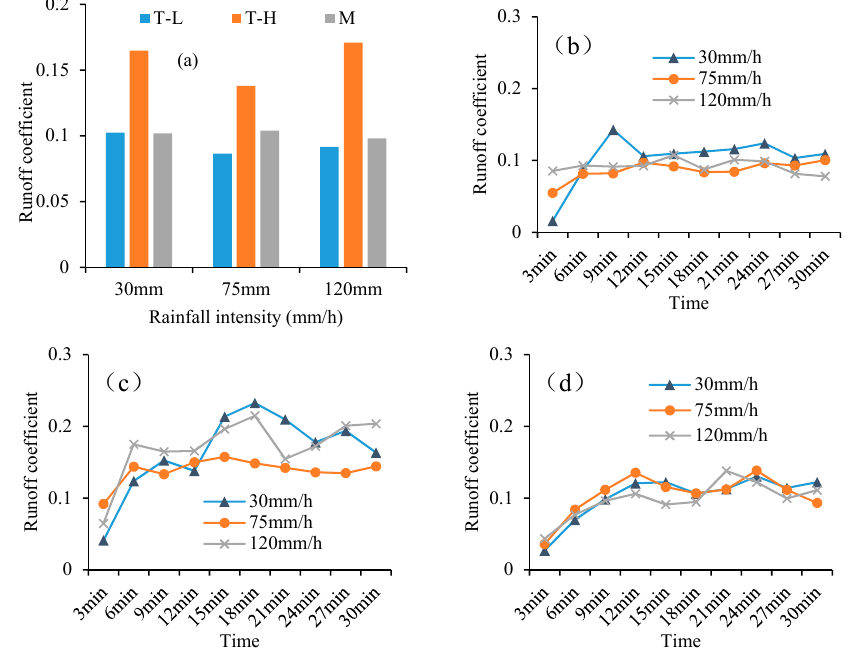
Figure 6. The general characteristics of the runoff coefficient ( a ) and the variations in the runoff coefficient with time for the T-L type ( b ); T-H type ( c ); and M type ( d ) plots. T-L stands for thin litter layer with low soil bulk density, T-H stands for thick litter layer with high soil bulk density, and M stands for moderate litter depth and soil bulk density.